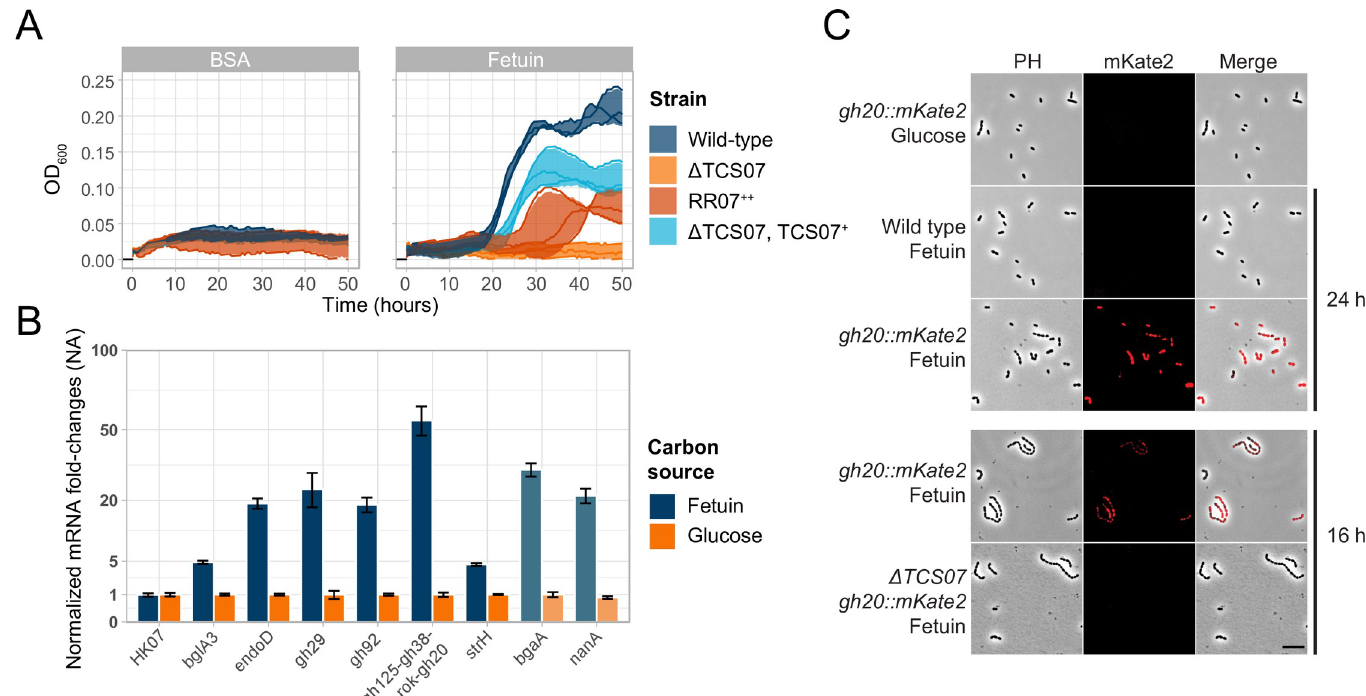
Fig 4. TCS07 is required for growth in and responding to a model glycan protein, fetuin. A) Growth experiments in fetuin (glycosylated) and BSA (not glycosylated). Indicated strains were grown to exponential phase (OD 600 = 0.3–0.4) in C+Y, at which point they were spun down and resuspended to OD 600 = 0.1 in PBS. 20 μ L was added to 180 μ L CDM supplemented with 2% fetuin or BSA. Lines depict replicates and colored shadows depict standard deviation. B) Growth in fetuin increase transcription of host-glycan metabolizing genes. D39 wild-type was grown to exponential phase (OD 600 = 0.3–0.4) in C+Y, at which point the culture was spun down and resuspended to OD 600 = 0.1 in PBS. 200 μ L was added to 1800 μ L CDM supplemented with 0.5% glucose or 2% fetuin. Cultures were grown to OD 600 = 0.2 at which point cells were harvested and RNA extracted. RT-qPCR was performed on the extracted RNA with primer sets for indicated genes. mRNA levels were normalized to gyrA and mRNA fold-changes for each gene are relative to glucose. Faded genes ( nanA and bgaA ) is not part of the identified regulon of TCS07. Performed in biological duplicates with standard deviation as error bars. C) TCS07 is required for induction of the gh125-gh38-ROK-gh20 operon. Fluorescence microscopy of wild type and Δ TCS07 strains with gh20 :: mKate2 fusion. The wild type strain with the gh20 :: mKate fusion was incubated in CDM with 2% fetuin for 24 h (after growth initiated) or in CDM with 0.5% glucose until exponential phase. The wild type strain without the fusion was incubated in CDM with fetuin as a negative control. The wild type and Δ TCS07 with the gh20 :: mKate2 fusion were incubated in CDM with 2% fetuin for 16 h (before growth initiated). Scale bar is 10 μ m.